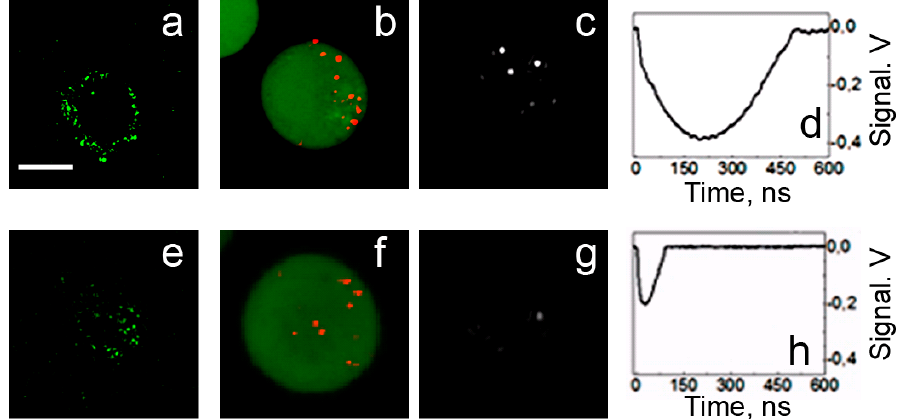
Figure 8. Confocal fluorescent, confocal scattering and time-resolved scattering images of prostate cancer C4-2B ( a , b , c ) and stromal HS-5 ( e , f , g ) cells: ( a , e )—confocal fluorescent images of AlexaFluor488 conjugated to PSMA antibody [60], ( b , f )—confocal scattering images of gold NPs (shown in red on a green fluorescent background that shows cell tracker dye), ( c , g )—time-resolved scattering images of the cells being exposed to a simultaneous pair of laser pulses at 532 nm and 787 nm and ( d , h )—the corresponding time-responses of PNBs [61]. Scale bar is 10 μ